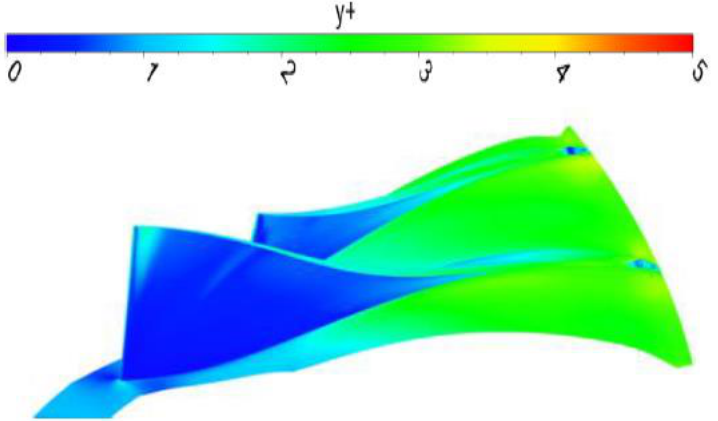
Figure 7. Distribution of y + . Table 2. Boundary condition